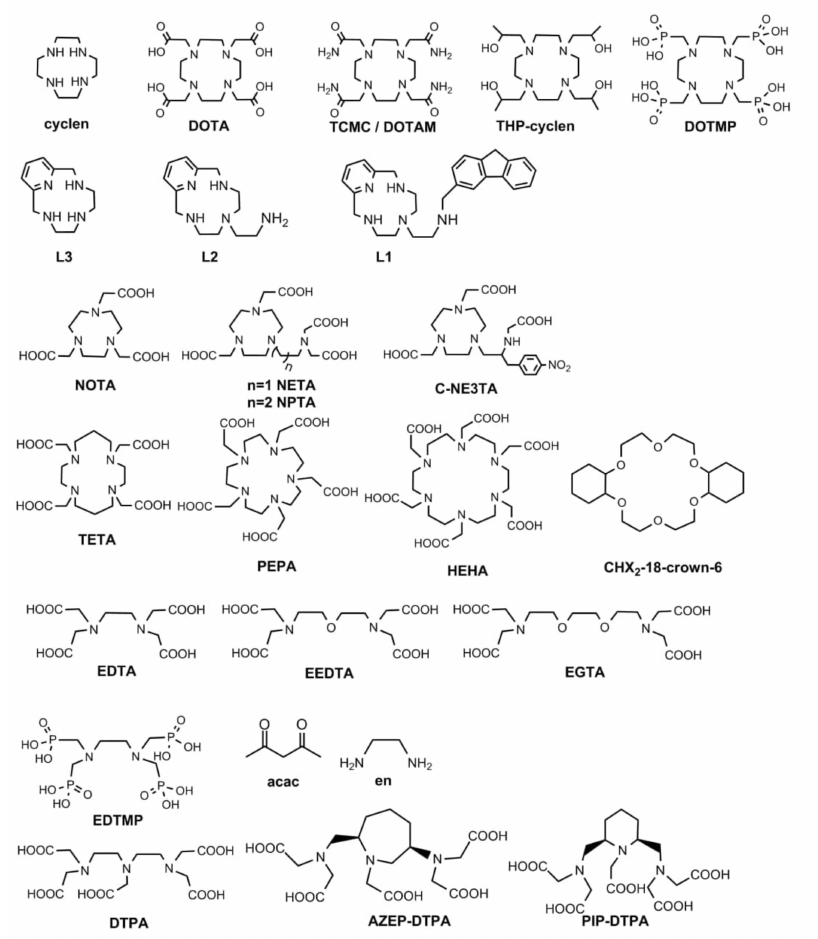
Figure 3. Ligands discussed in this paper.